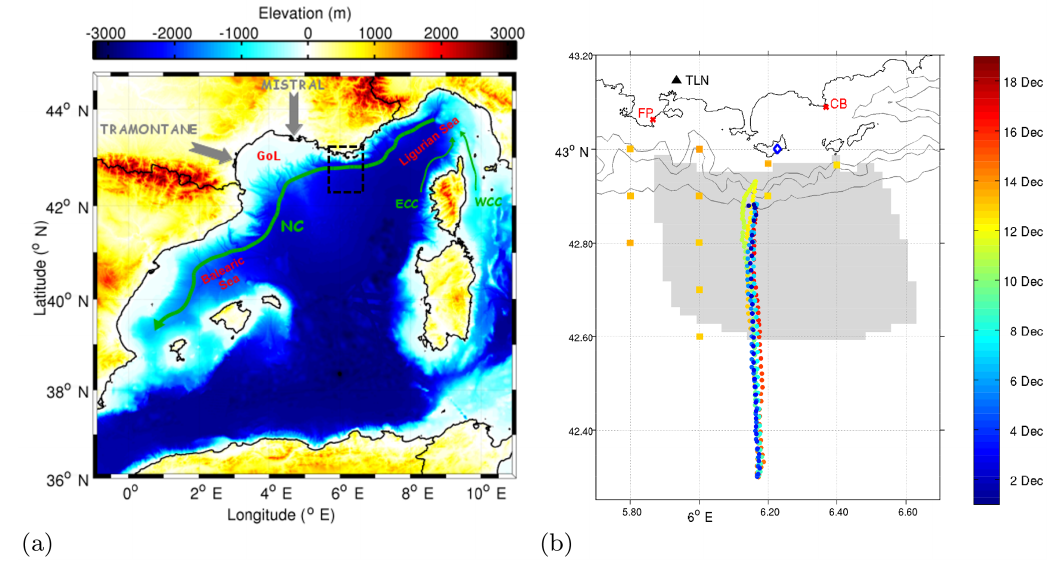
Figure 1. (a) The western Mediterranean Sea, including northern circulation branches and main winds. The region of study is marked as a dashed black square. The following acronyms are used: GoL: Gulf of Lion, NC: Northern Current, WCC: Western Corsica Current, ECC: Eastern Corsica Current. (b) Details of the region of study including the synoptic measurements carried out during the experiment (2–19 December 2011). The gray area is the high-frequency (HF) radar surface current field coverage, while the two red crosses indicate the HF radar sites at Fort Peyras (FP) and Cap Bénat (CB), in the Toulon (TLN) area. The orange square marks represent the conductivity– temperature–depth (CTD) stations, while the dot array at 6.20 ◦ E shows the track of the repeated glider transects. CTD stations and glider tracks are color coded in time. The blue diamond indicates Porquerolles weather station’s position. Bathymetric lines are at 500, 1000 and 2000m